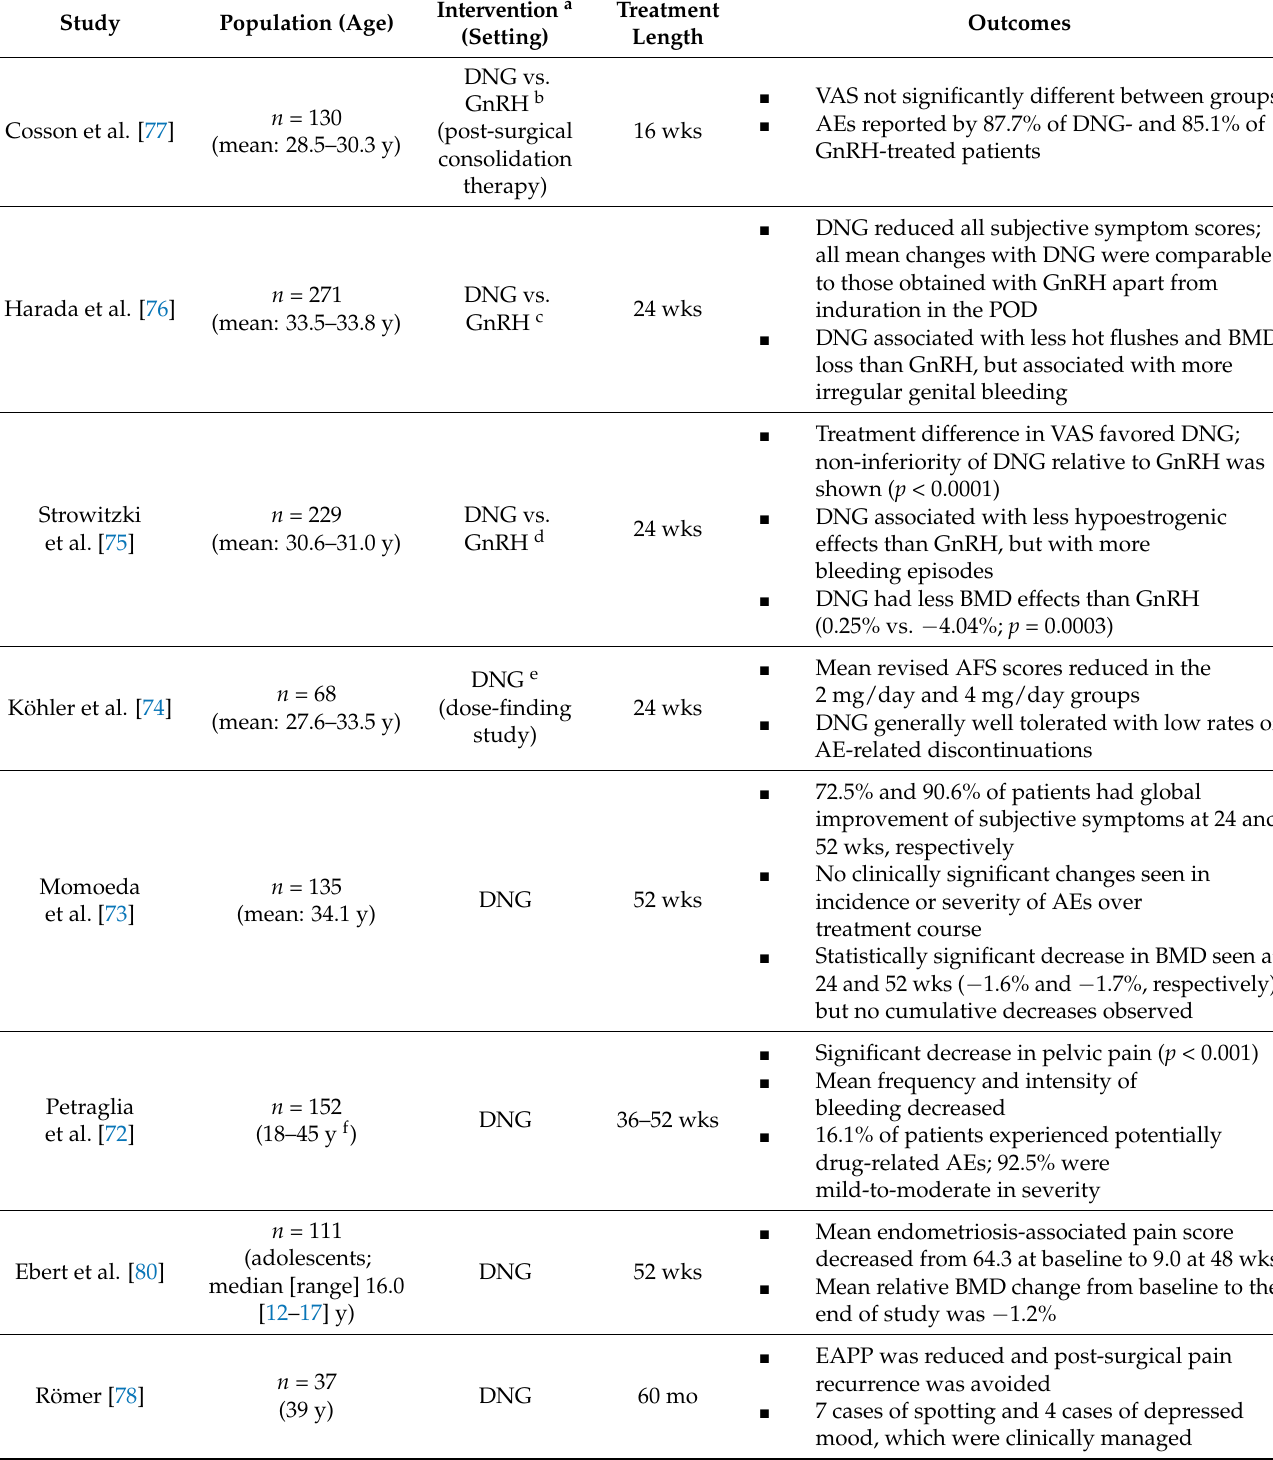
Table 2. Overview of studies supporting long-term treatment with